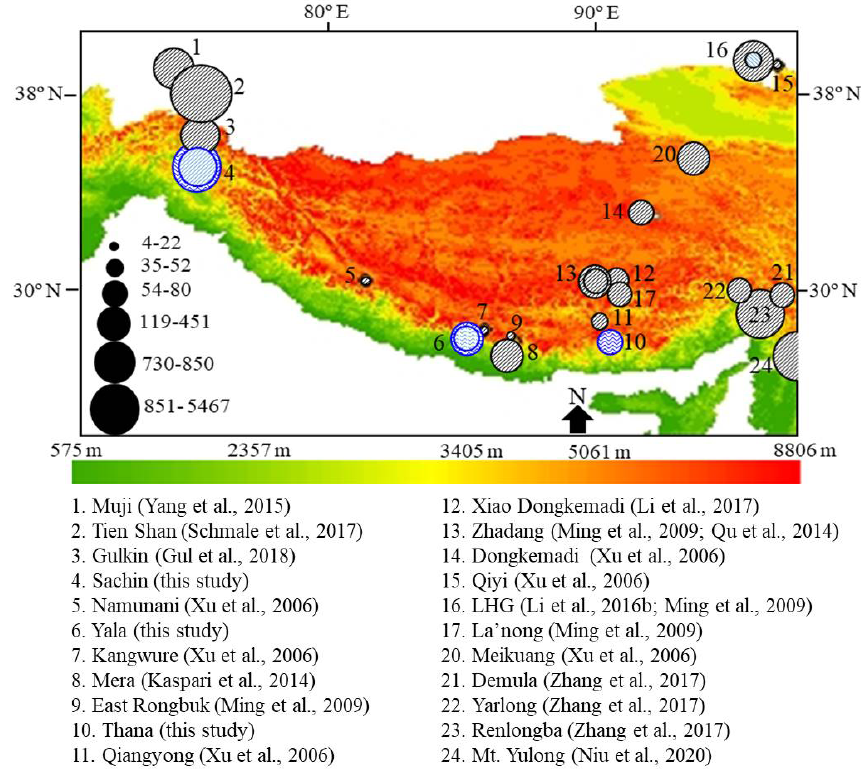
Figure 3. Black carbon concentrations (ngg − 1 ) in snow/ice samples in the Himalayas, Karakoram, and Tibetan Plateau in previous studies (black circles) and this study (blue